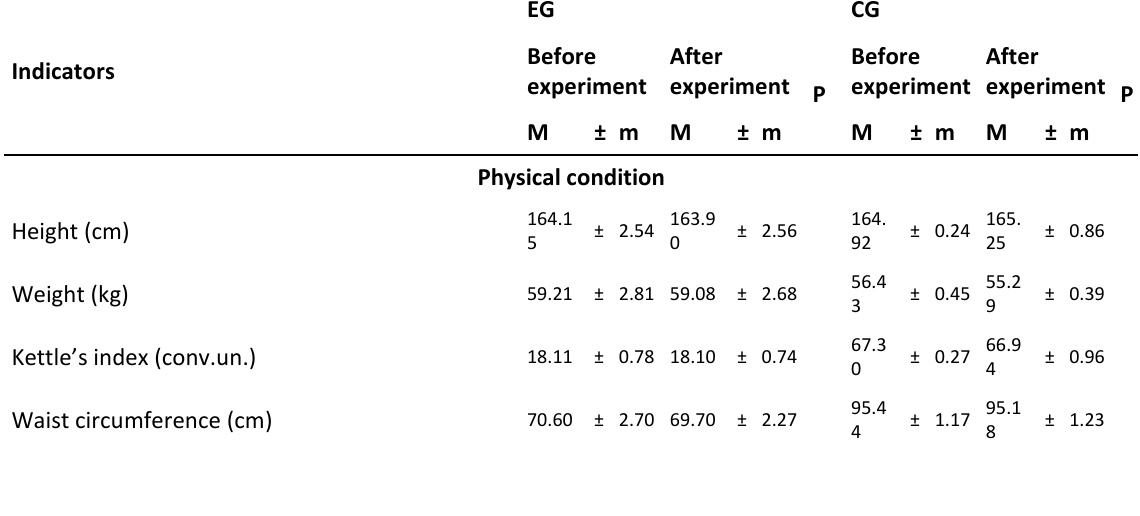
Table 1. Dynamic of students’ indicators in corrected variant of physical culture-health related technology for prophylaxis of respiratory disorders (girls)